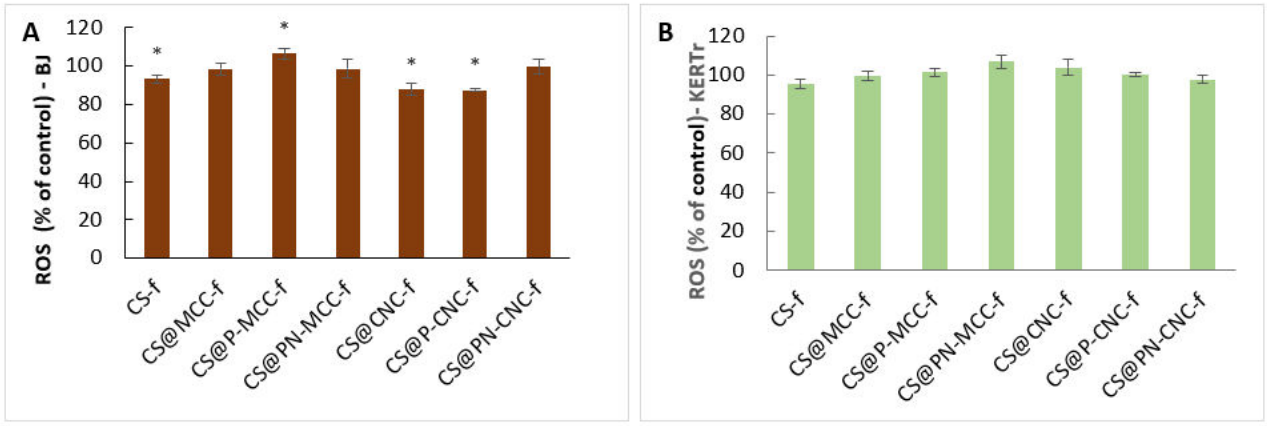
Figure 5. The content of reactive oxygen species in cells of BJ ( A ) and KERTr ( B ) incubated for 24 h with chitosan-cellulose biocomposites, n = 6. * p <